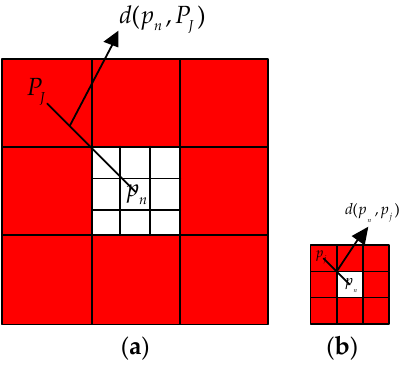
p and its eight neighboring pixels. ( b ) Central n